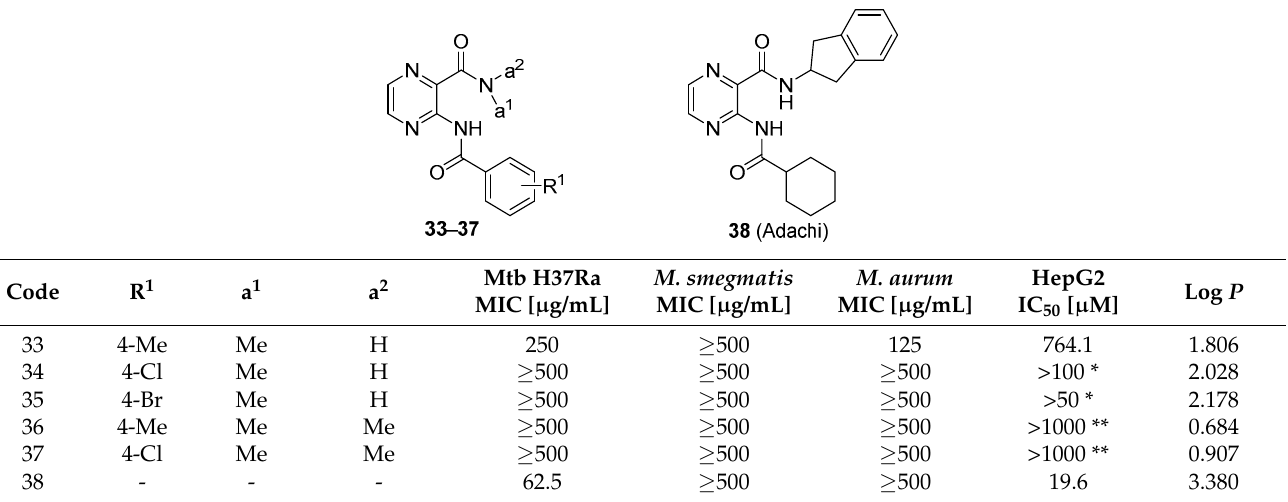
Table 4. Antimycobacterial activity and HepG2 cytotoxicity of compounds’ cyclic (pteridine) deriv ‐